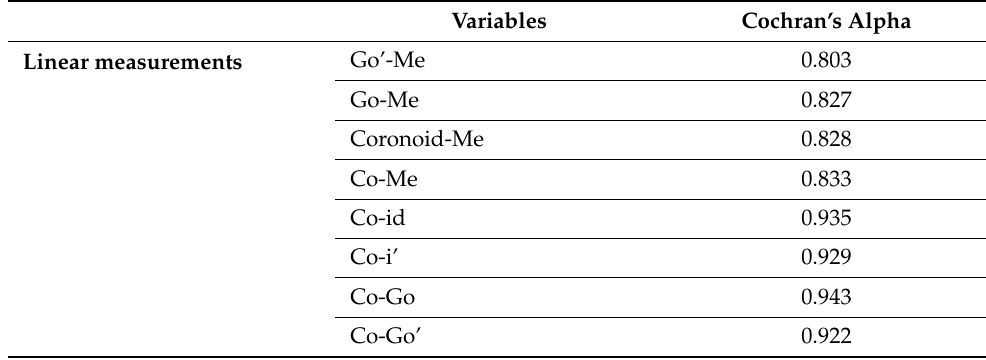
Table 4. Reliability performed on 20 randomly selected subjects re-measured 3 weeks